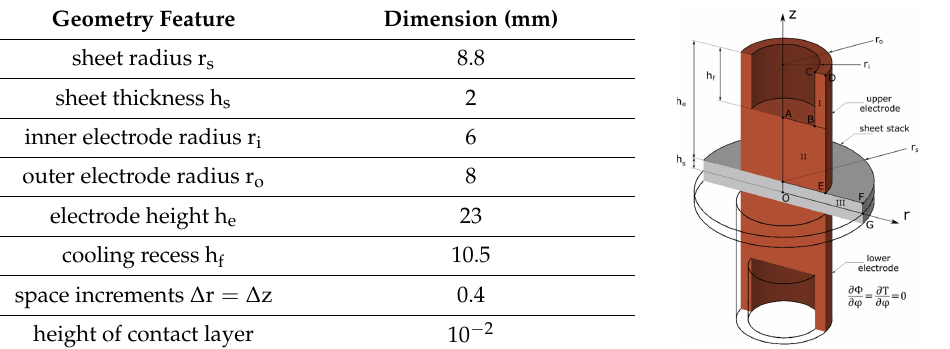
Table 1. Geometry features and